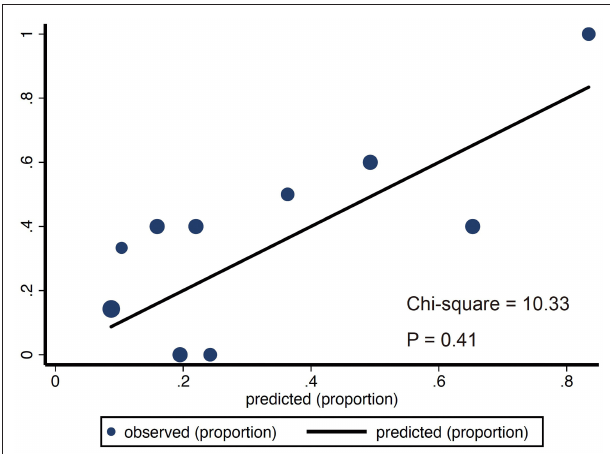
FIGURE 5 | The calibration curve of nomogram for predicting poor prognosis in the validation ( p = 0.41) dataset. The calibration focused on the accuracy of the absolute risk prediction of the model (i.e., the consistency between the probability of poor prognosis predicted by the model and that actually observed). The y-axis represents the actual rate of poor prognosis. The x-axis represents the predicted probability of poor prognosis. For a nomogram with better calibration, the scatter points should be arranged along a 45 ◦ diagonal line. The Hosmer-Lemeshow goodness-of-fit test is often used to compare whether significant differences exist between the prediction probability and the actual occurrence, with p > 0.05 indicating no statistically significant difference, and the calibration of the model was